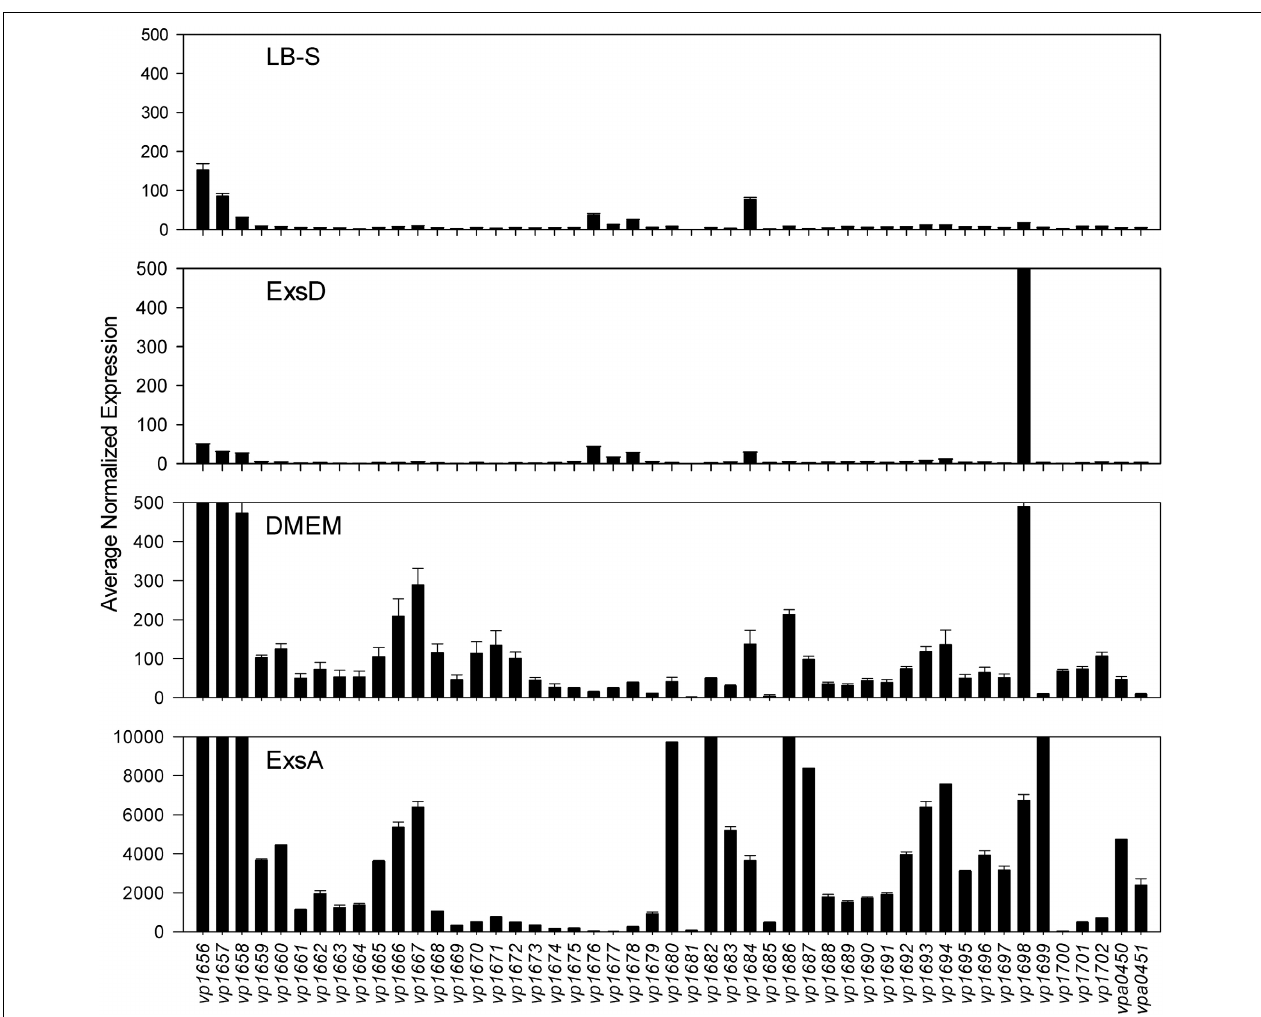
FIGURE 2 | Average normalized expression ( n = 2 replicates) for T3SS1 associated genes ( vp1656 — vp1702 ; vpa0450 — vpa0451 ) in T3SS1 non-inducing (LB-S, ExsD) and inducing (DMEM, ExsA) conditions. LB-S: NY-4 was subcultured into LB-S media and grown for 3h. ExsD: NY-4:p exsD was subcultured into LB-S and IPTG induced to express exsD for 3h. DMEM: